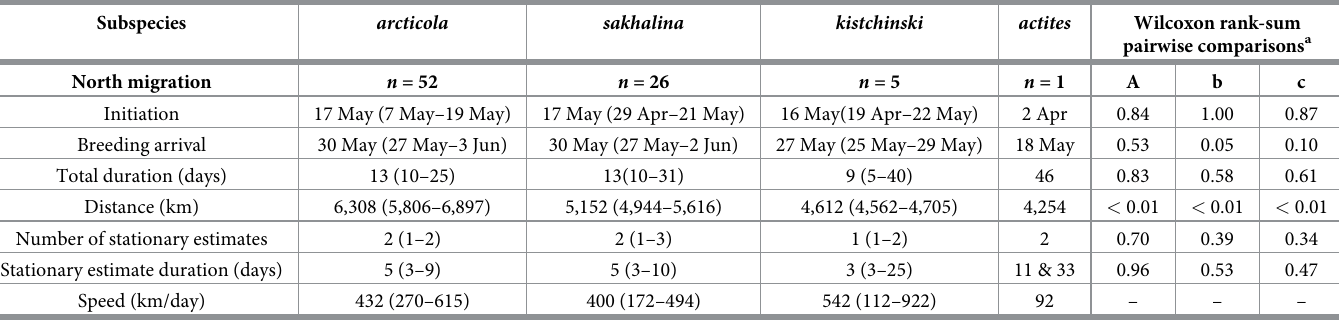
a “a” indicates a pair-wise comparison between arcticola and sakhalina ; “b”: arcticola and kistchinski ; “c”: sakhalina and kistchinski . No statistical comparisons were made with the actites subspecies due to a low sample size. P-values are